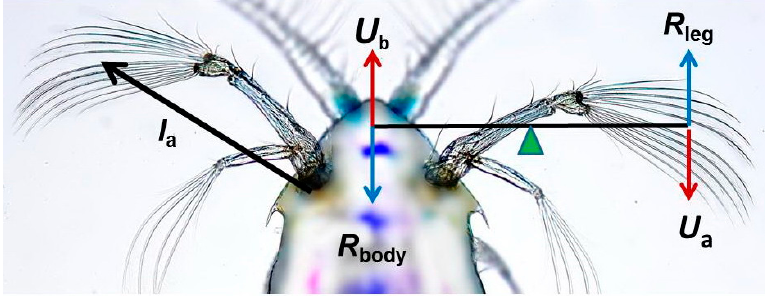
Figure 13. Second antennas of Pontella mediterranea . The black arrow on the left shows the length of the antennae l a ; other arrows show the forces and speeds of the body and legs. The magnitudes of velocities U b (= U ) and U a determine the location of a simulated rowlock (green triangle) of an oar model.